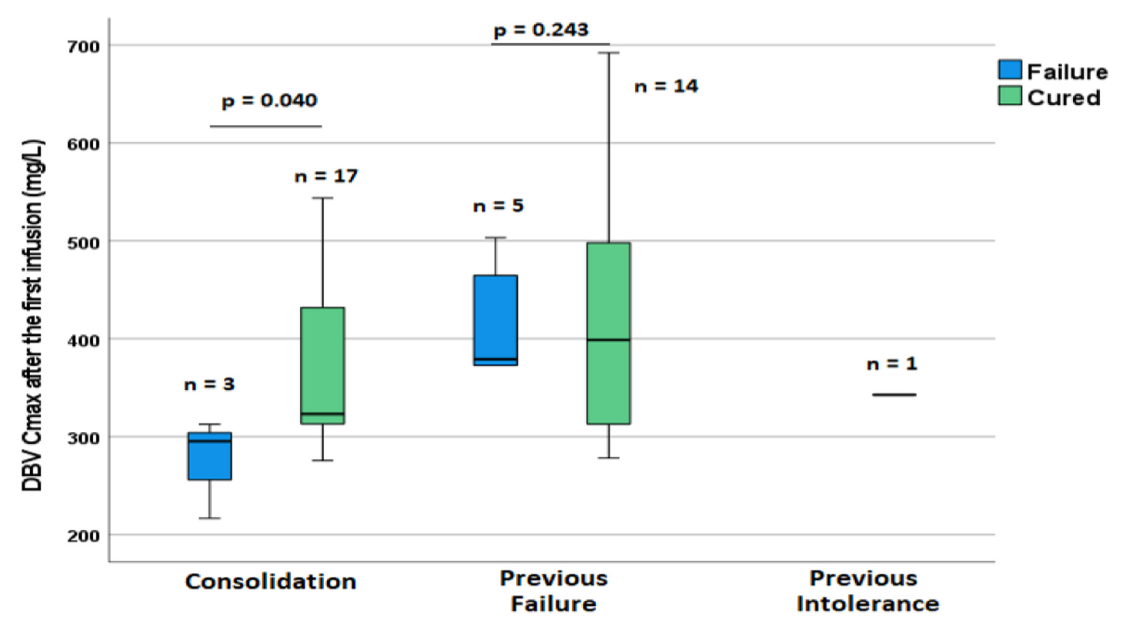
Figure 3. Differences in DBV levels between patient groups based on the reason for using DBV with regard to previous treatments and the outcome of therapy with DBV.